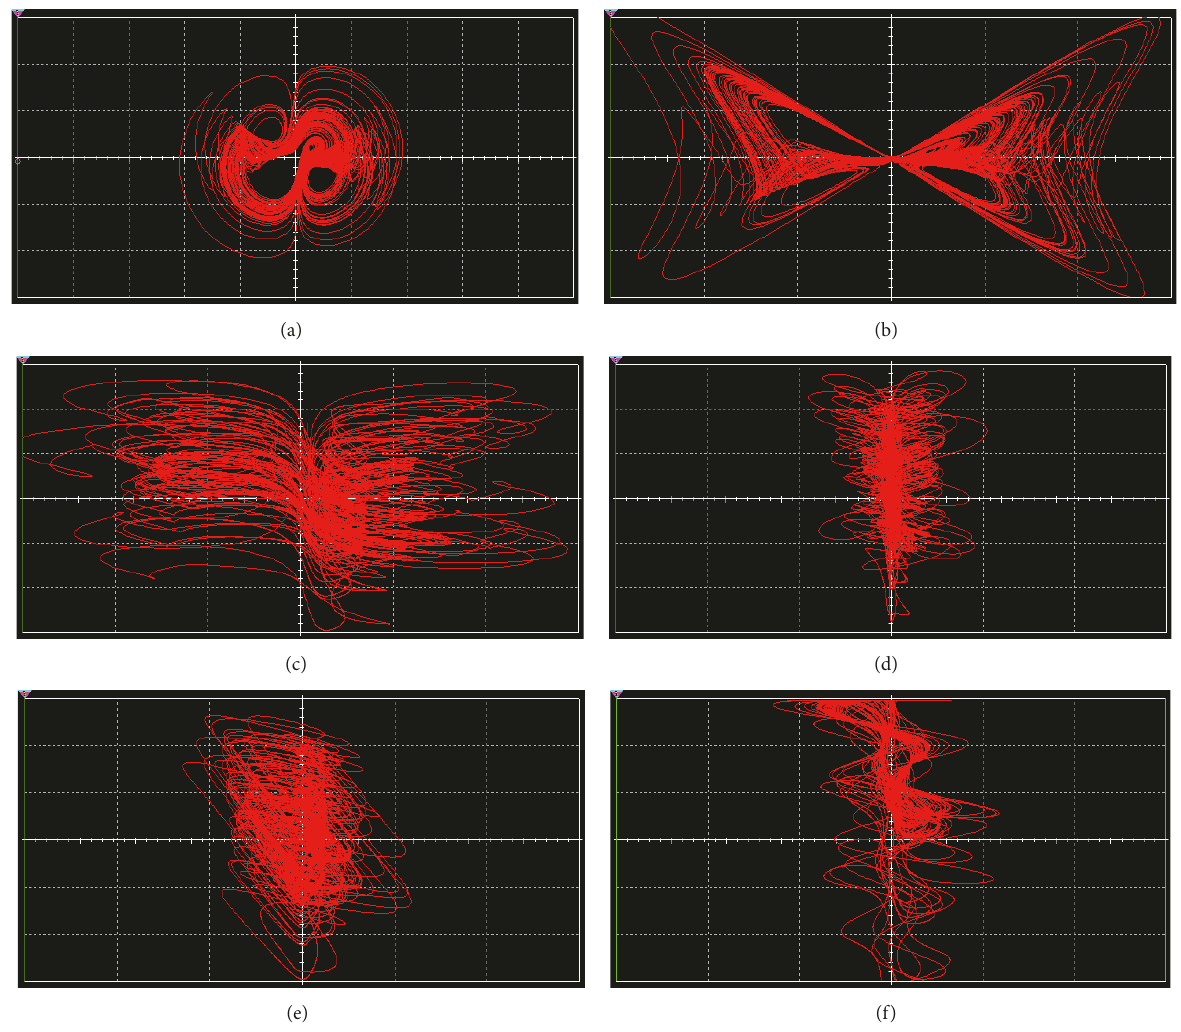
Figure 6: Multisim implementation of the chaotic System (17): (a) x-y plane with scales 5 V /div and 2 V /div, (b) x-z plane with scales 2 V /div and 1 V /div, (c) x-w plane with scales 2 V /div and 1 V /div, (d) z-w plane with scales 2 V /div and 1 V /div, (e) y-w plane with scales 2 V /div and 1 V /div, and (f) y-u plane with scales 2 V /div and 2 V